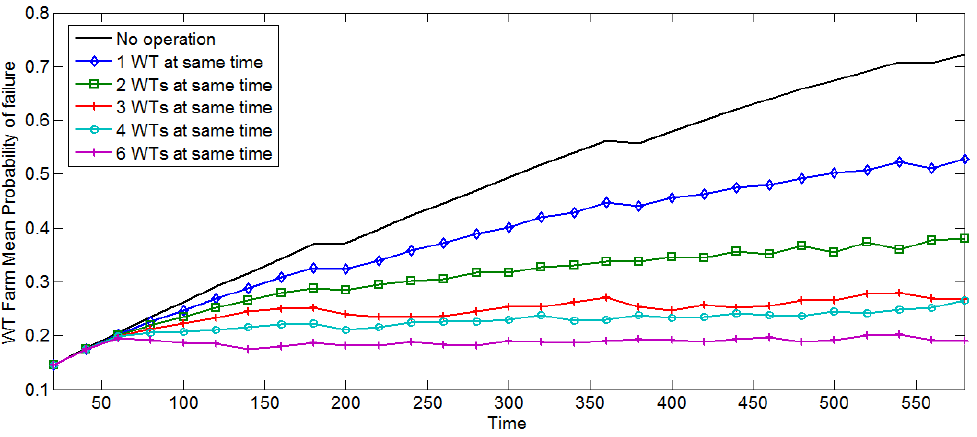
Figure 8. Average fault probability of the offshore wind farm.